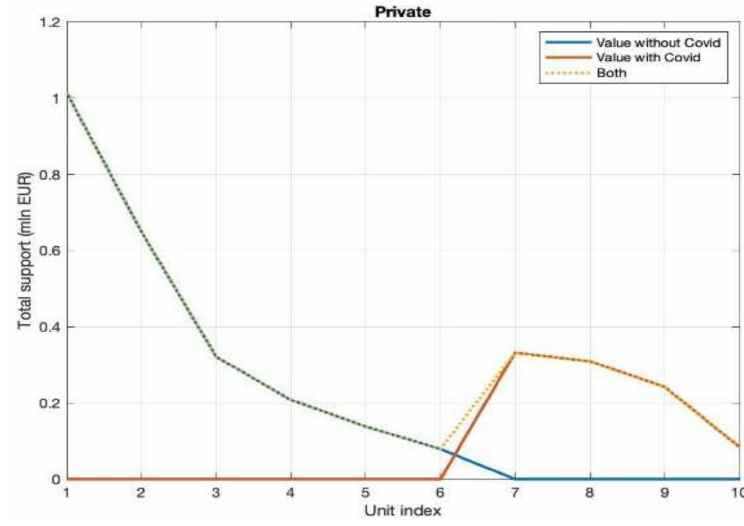
Figure 9. Support characteristics—private sector (COVID division, without COVID).